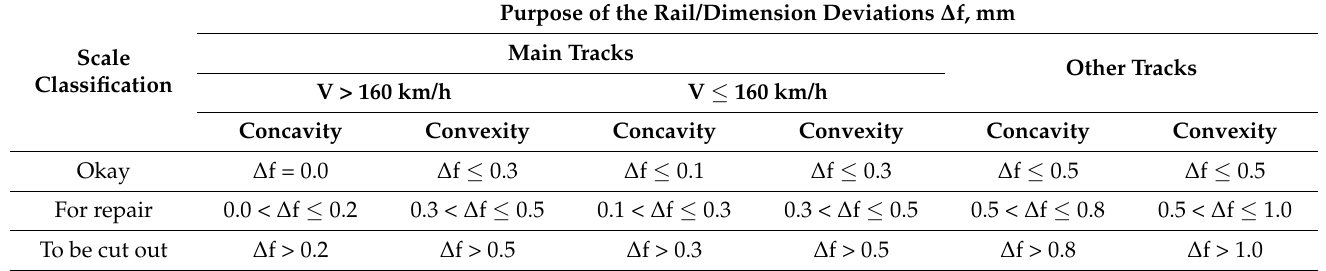
Table 5. Permissible vertical straightness